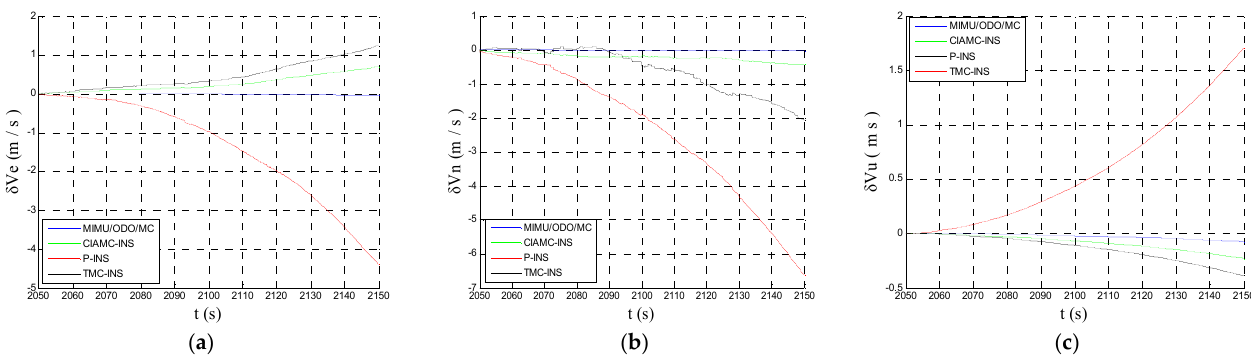
Figure 12. Velocity error curves of four algorithms without GNSS signal. ( a ) East velocity error curves; ( b ) north velocity error curves; ( c ) upwards velocity error curves.